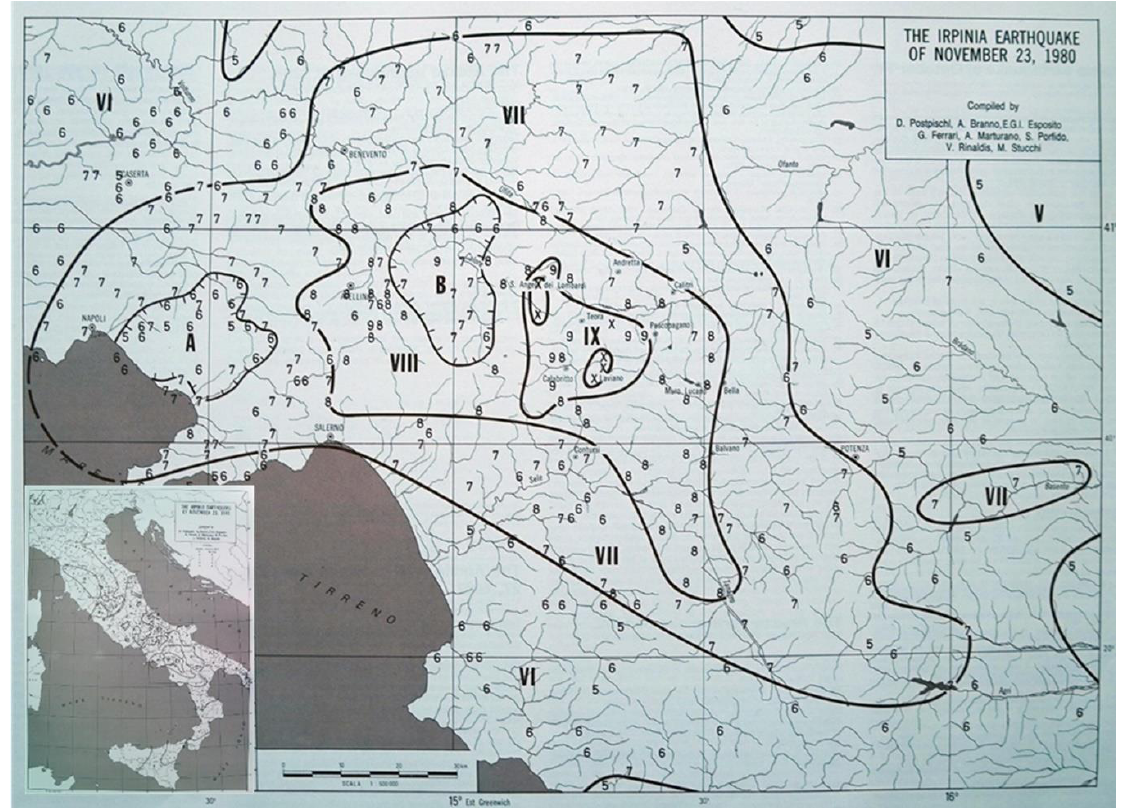
Figure 1. Isoseismal Map of the 23 November 1980 Irpinia-Basilicata earthquake [1].